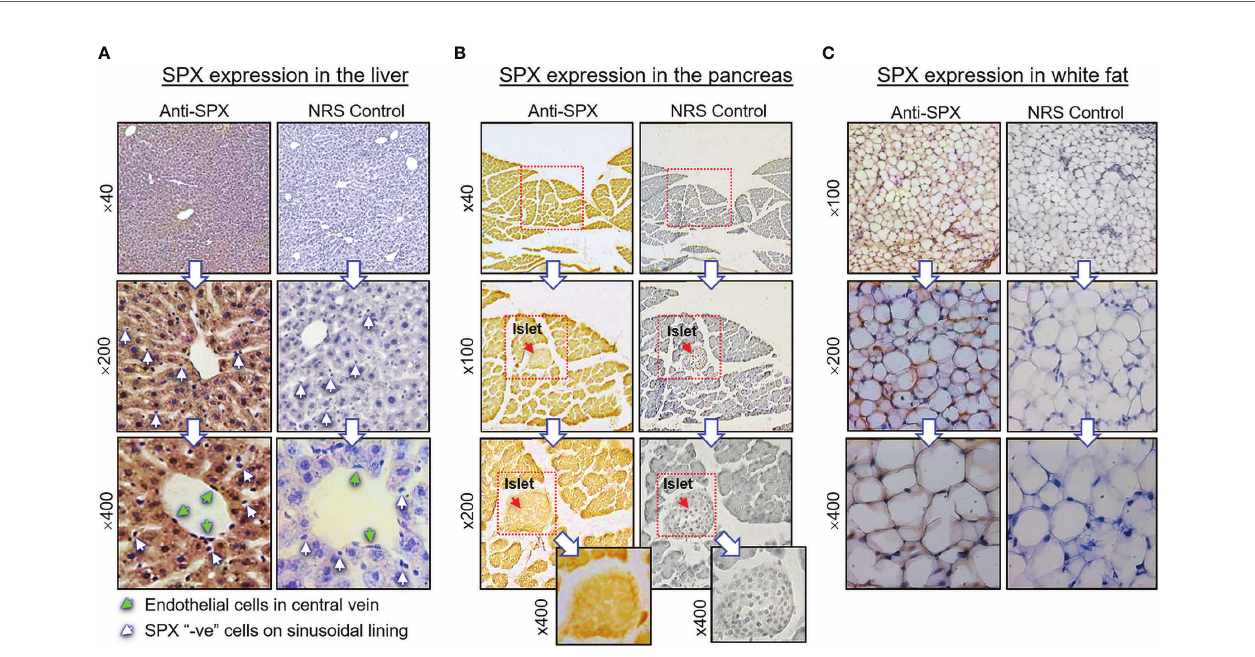
FIGURE 4 | Histological distribution of SPX expression in the liver, pancreas and white fat. Immunoreactivity of SPX was detected by IHS in tissue sections (10 µm in thickness) prepared from (A) the liver, (B) pancreas, and (C) white fat of the mouse with SPX antiserum (anti-SPX, 1:600). In these cases, speci fi c signals of SPX could be noted in the hepatocytes, endothelial cells in the central vein of hepatic lobules, endocrine cells in the islets of Langerhans, acinar cells of exocrine pancreas, and adipocytes forming the fat mass. Parallel staining with a similar dilution of normal rabbit serum (NRS) was used as the negative control and counterstaining with hematoxylin was routinely performed after signal development of SPX. The numbers shown on the side of individual panels (×40, ×100, ×200, and ×400) represent the magni fi cation for the respective